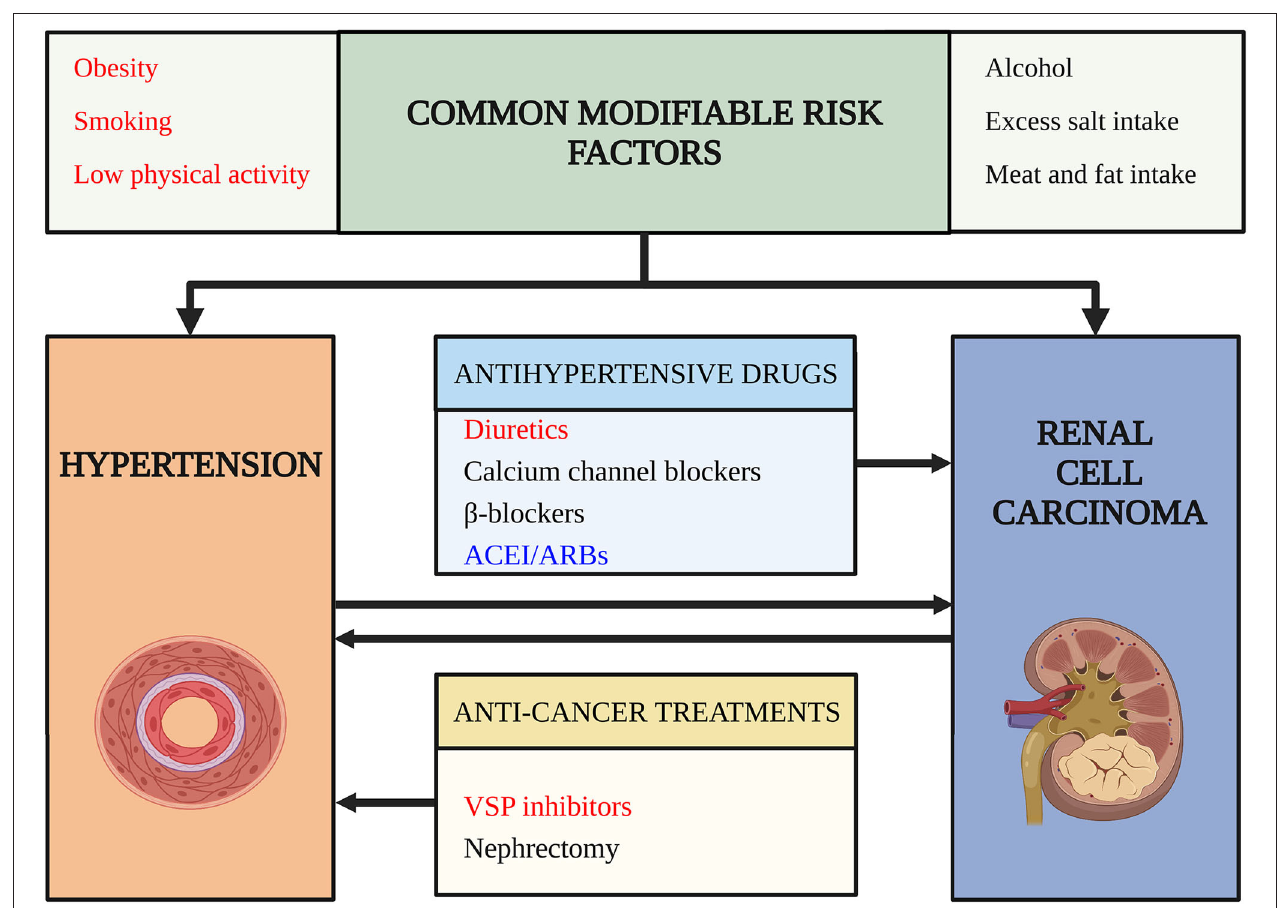
FIGURE 1 | Risk factors for comorbidity of hypertension (HTN) and renal cell carcinoma (RCC). This figure outlines risk factors for the comorbidity of hypertension and renal cell carcinoma. Arrows indicate a potential causality relationship. Words in red color highlight risk factors confirmed by high-level evidence and have achieved consensus. Words in black color indicate risk factors lack strong evidence or the evidence are still conflictive. Words in blue indicate risk factors that may decrease the risk of comorbidity and have protective roles. ACEI/ARB, angiotensin-converting enzyme inhibitors/angiotensin receptor blockades; VSP, vascular endothelial growth factor signaling